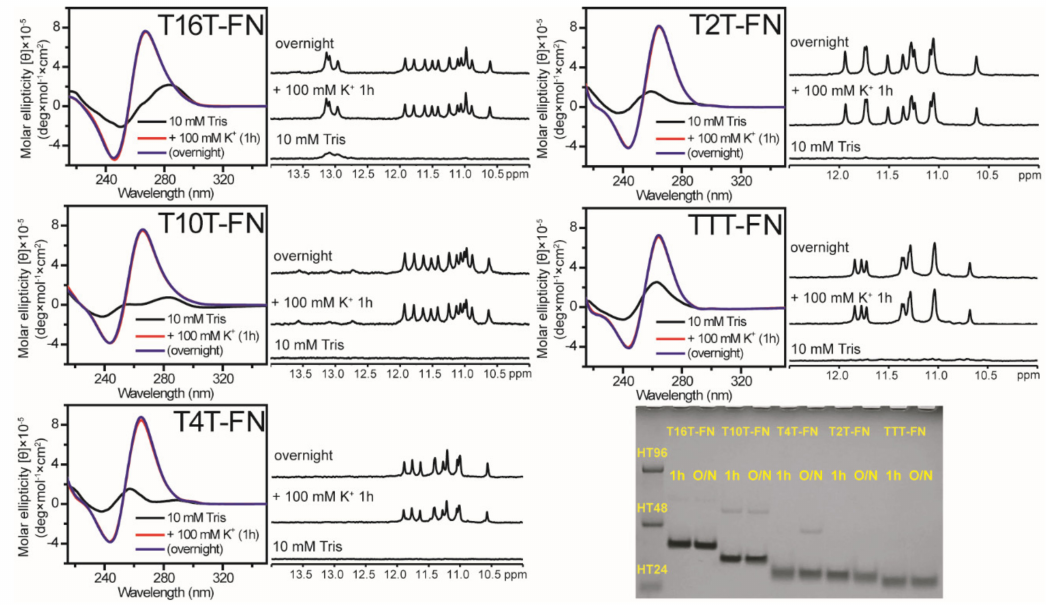
Figure 4. The e ff ect of flanking nucleotides on G4 formation of (G 3 TG 3 N m G 3 TG 3 )-FN sequences. CD and NMR spectra of T16T-FN, T10T-FN, T4T-FN, T2T-FN, and TTT-FN in 10 mM Tris and after 1